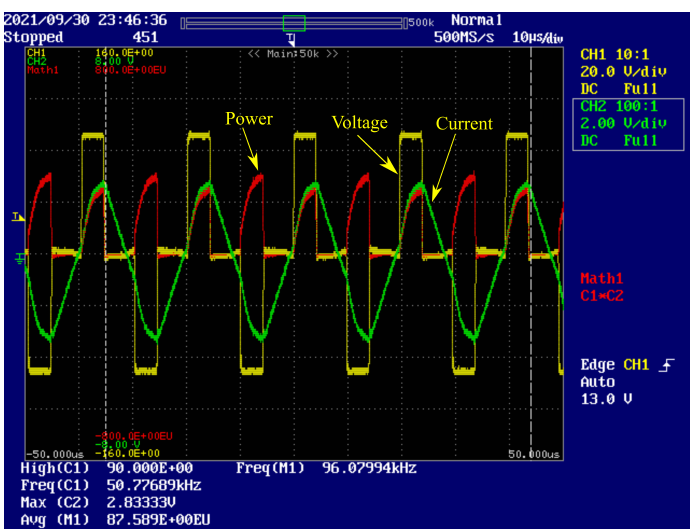
Figure 20. Illustration of converter output at 2 kV output